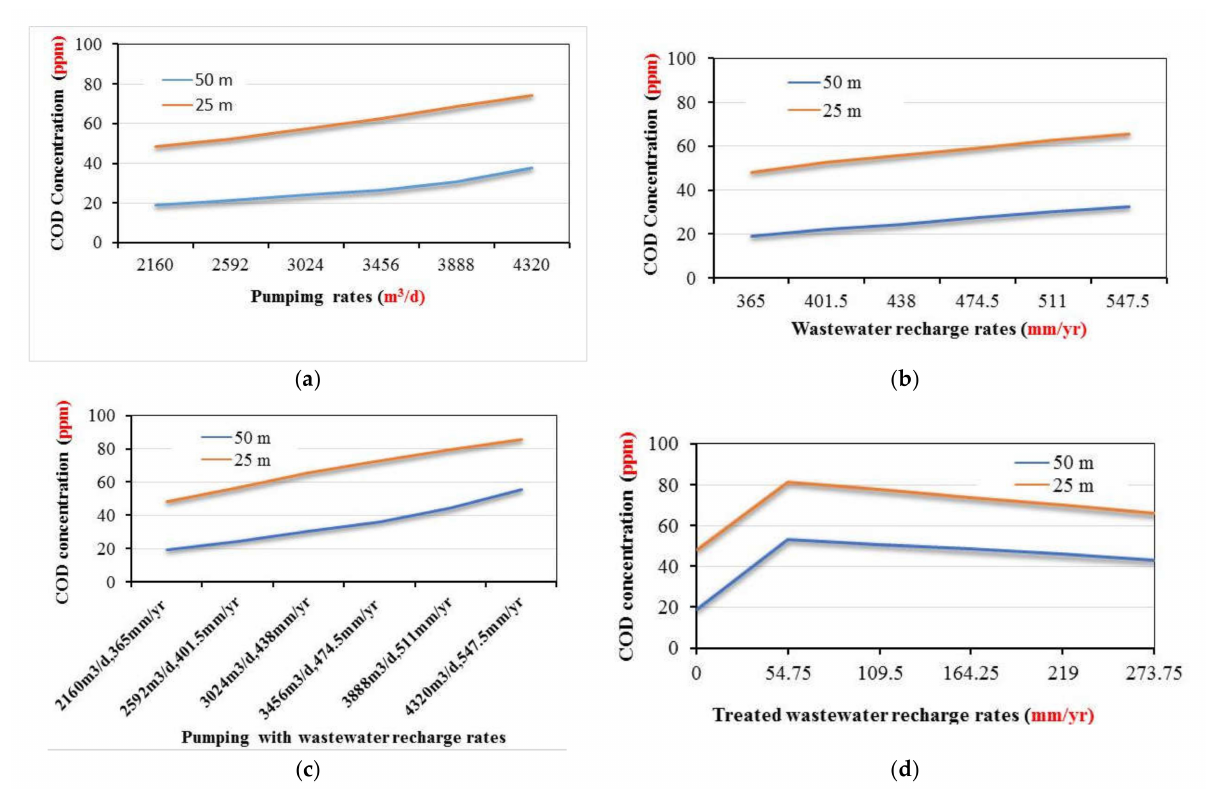
Figure 10. Relation between COD concentrations at different depths and ( a ) pumping rates, ( b ) recharge rates, ( c ) pumping with recharge rates, and ( d ) treated wastewater recharge rates.